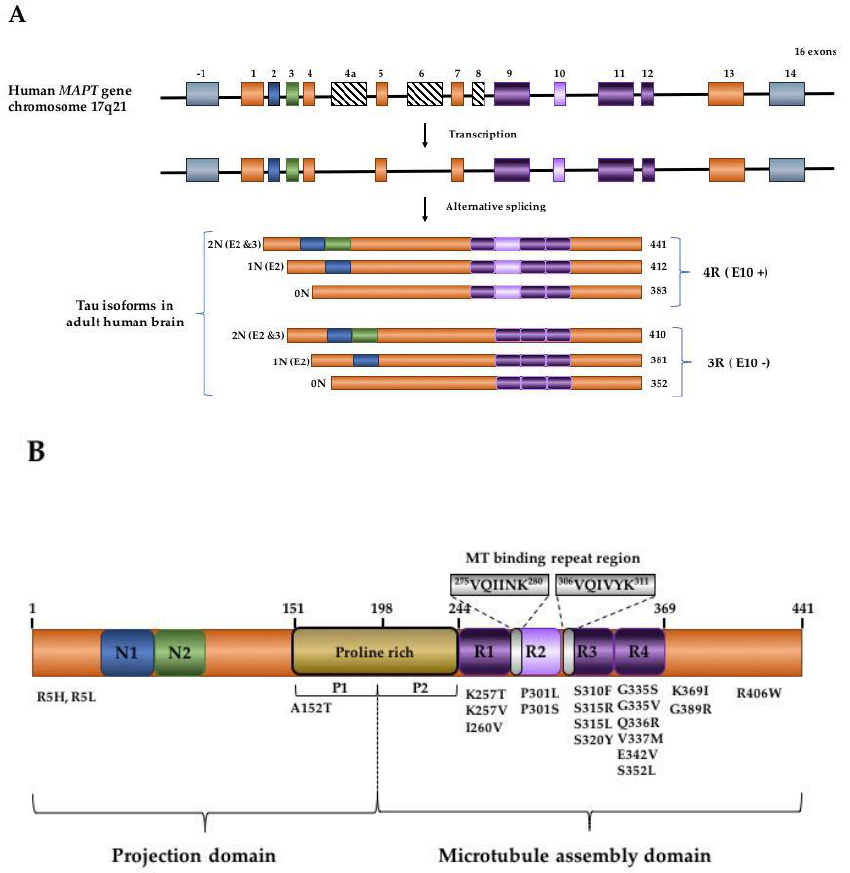
Figure 1. The human MAPT gene, tau isoforms in the human brain, structure, and mutations. ( A ) . Schematic of the MAPT gene on chromosome 17q21.31 which compromises 16 exons [10,31]. There are six main isoforms of tau that are generated from the alternative splicing of E2, E3, and E10. The splicing of E2 and E3 generates isoforms containing either 0, 1, or 2 amino-terminal inserts of 29 amino acids known as 0N, 1N, and 2N, respectively. The presence or absence of the second repeat R2 domain (light purple), which is encoded by exon 10, categorize the isoforms with 3R or 4R [32]. ( B ). Tau major domains are divided into the projection domain and the assembly repeat domain in the carboxy-terminal sections separated by a proline-rich region. The projection domain comprises residues 1–197 and is not directly involved in microtubule (MT) binding. The proline-rich region is subdivided into P1 and P2, separated by the chymotryptic cleavage site at residue 198 that divides the assembly and projection domain [33,34]. The C-terminal assembly domain is important for MT binding and assembly. The assembly domain contains the MT binding repeat region followed by a flanking region that shows a weak sequence similarity to the repeat domain [33]. The four repeats, around 30–31 residues each, are labeled R1-R4. Both P2 and the flanking regions contribute to MT assembly and binding. The MT repeat region also contains the “paired-helical filament core”, which serves as a principal structure for forming tau aggregates [35,36]. Within this structure, two hexapeptide motifs [37] important for aggregation have been highlighted in gray. Major disease-associated missense mutations that alter the sequence are also